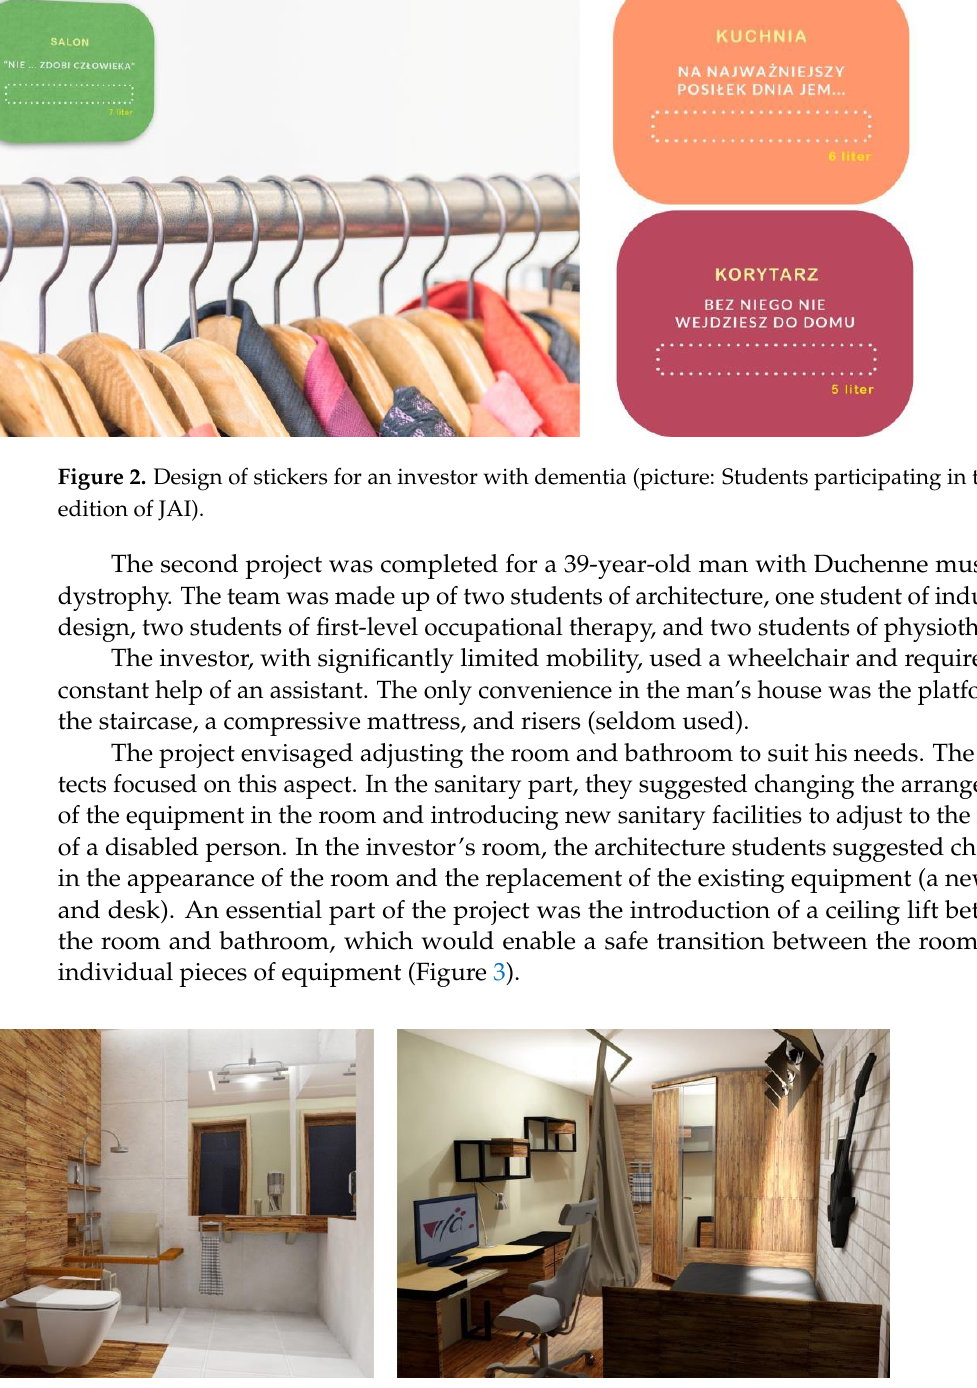
Figure 3. Interior IL.03. Design project for an investor with muscle atrophy—visualization (picture: students participating in the 8th edition of JAI).